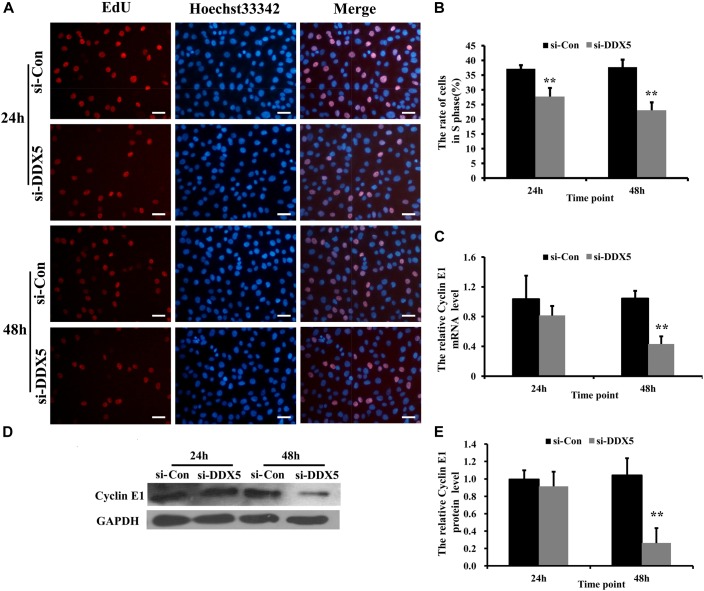
DDX5 required for the entry of cells into the S phase. (A) EdU DNA proliferation in vitro detection shows that DDX5 siRNA (si-DDX5) treatment significantly decreased the number of cells in the S phase compared with the negative control groups (si-Con), bar = 50 μm. (B) Bar chart showed the rates of cells in the S phase. (C) Bar chart showed the relative Cyclin E1 mRNA levels of MG63 cells detected by qRT-PCR at 24 and 48 h after transfection with si-DDX5 or si-Con. (D) Expression of Cyclin E1 detected by Western blot at 24 and 48 h after transfection with si-DDX5 or si-Con. (E) Bar chart showed the relative Cyclin E1 protein level (n = 4), ∗∗P < 0.01 vs. si-Con.